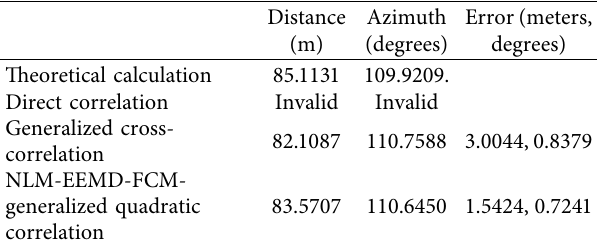
Table 2: Comparison of positioning results of three delay esti- mation